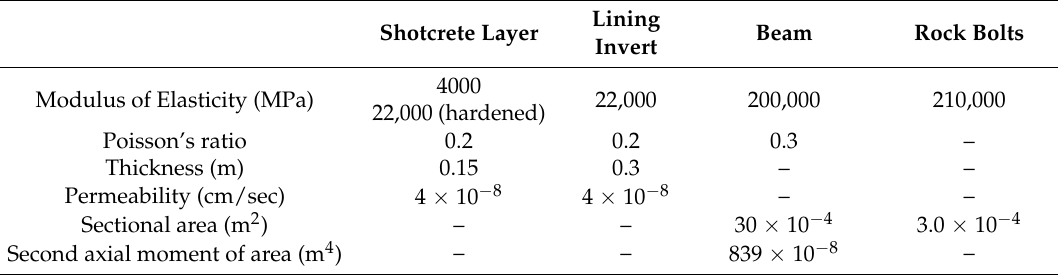
Table 2. The input parameters regarding the liner used in numerical modeling.